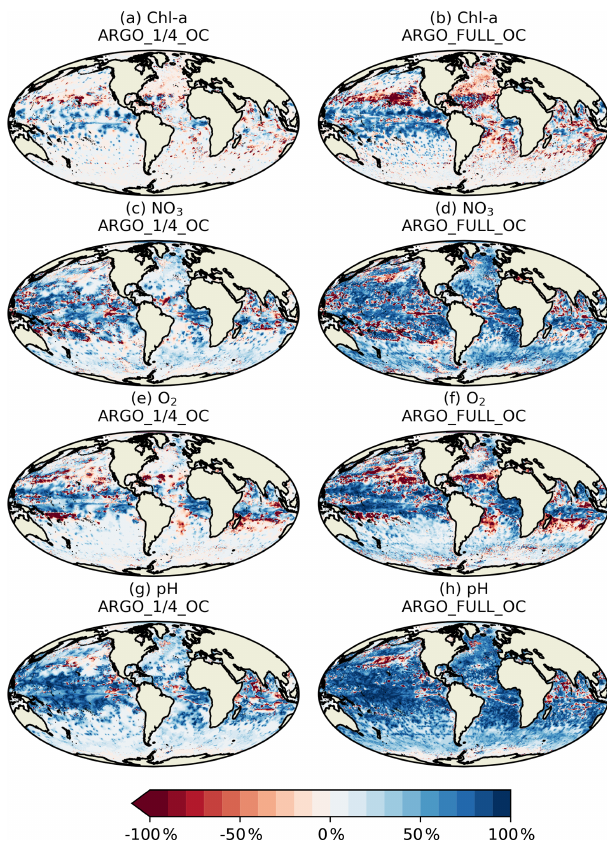
Figure 10. MAE red_% over OC for Chl a , NO 3 , O 2 , and pH for December 2009 at 100m of